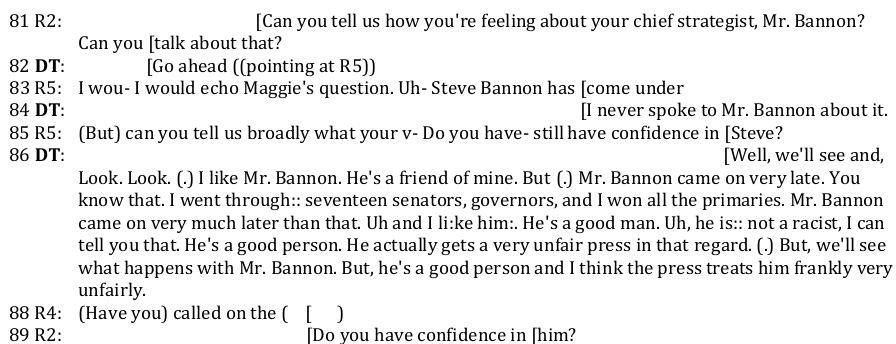
Figure 9. Transcript excerpt 81–89.